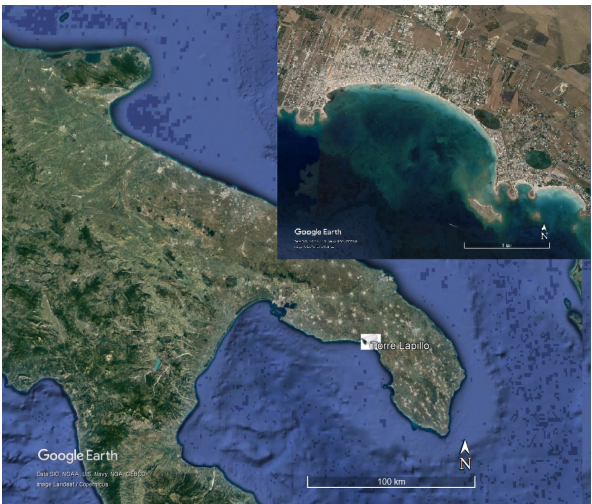
Figure 9. Torre Lapillo location along Apulia region coasts in the southern of Italy.